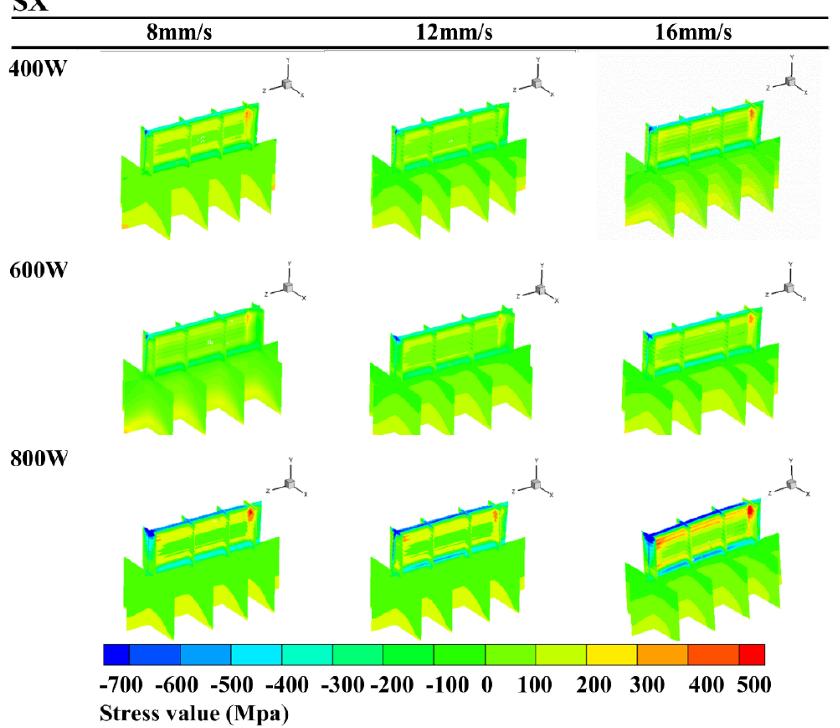
Figure 6. The XX stress distributions under different scanning speed and laser power values when the layer thickness is 0.4 mm. Table 5. Maximum residual stresses of all the samples. Trial